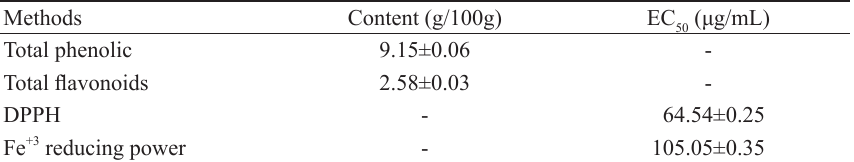
Total phenolic and flavonoids contents and antioxidant activity of the ethanol extract obtained from Ageratum fastigiatum branches.